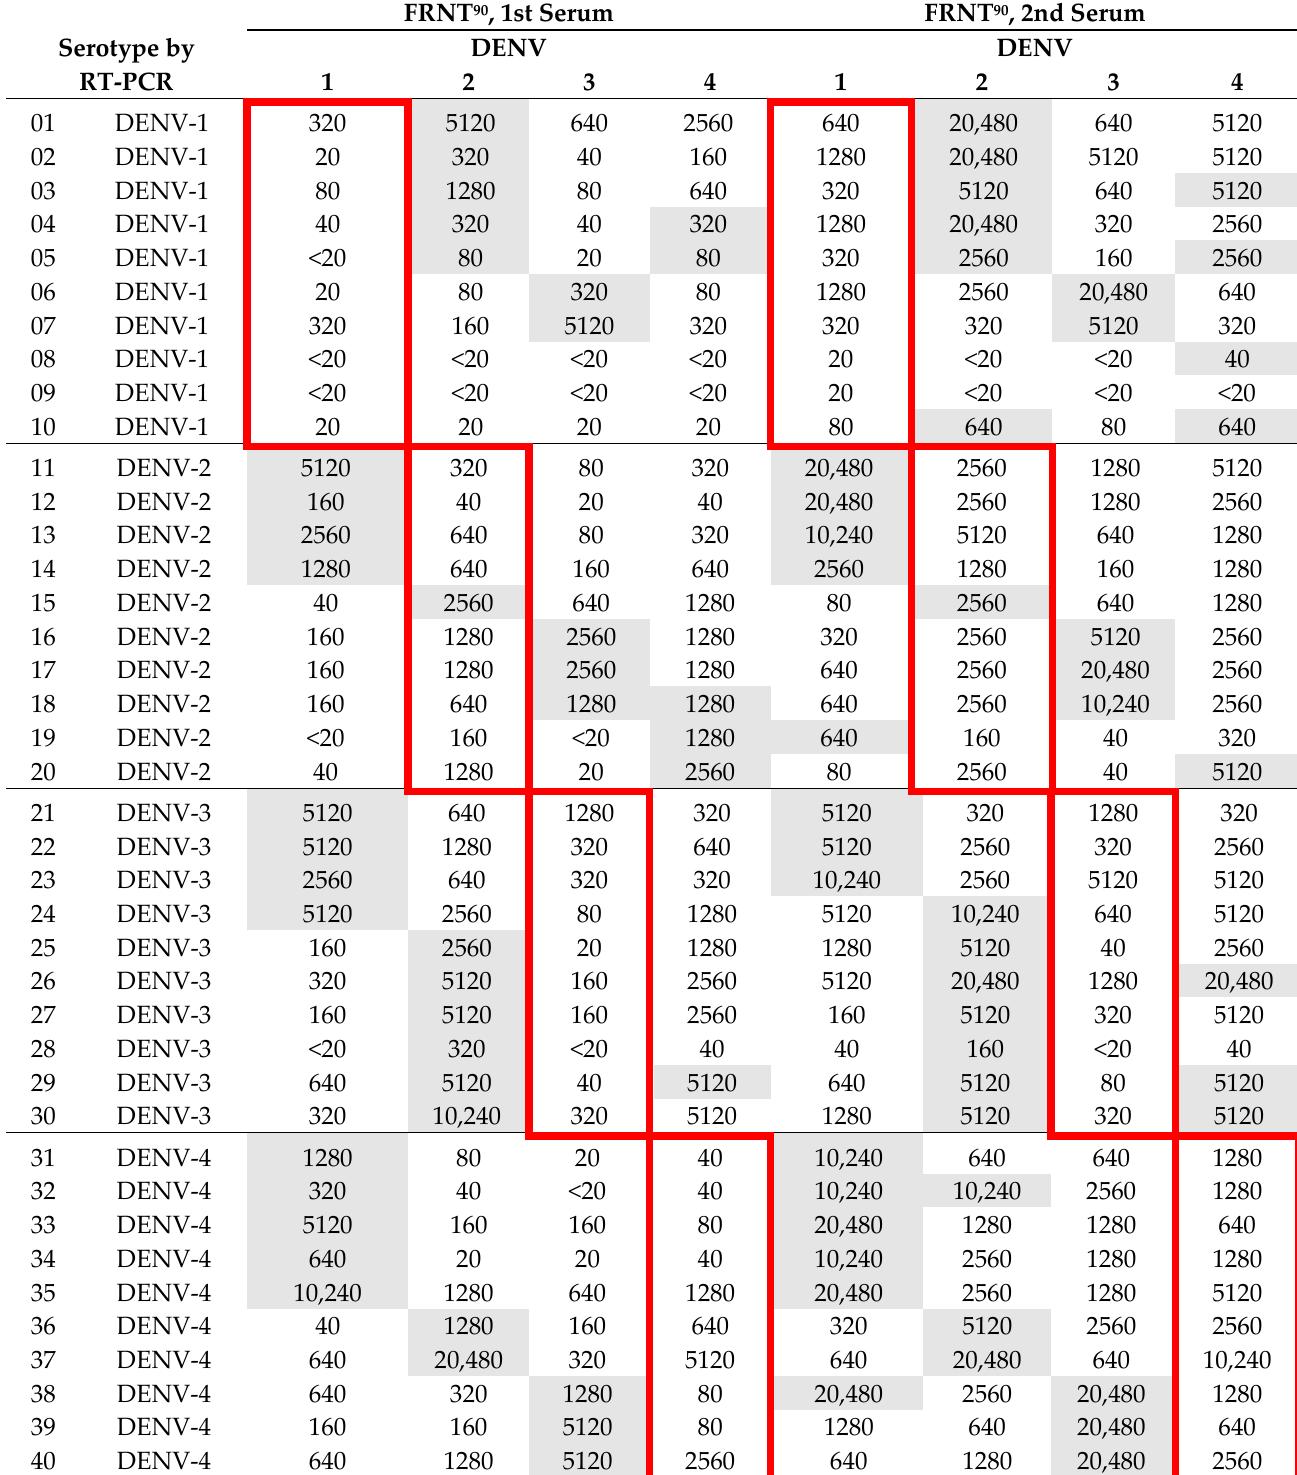
no.15 (Table 2), showed a matching antibody response to the corresponding reference strains. Table 2. Neutralization titers to DENV-1–4 reference strains using RT-PCR confirmed DENV sera.